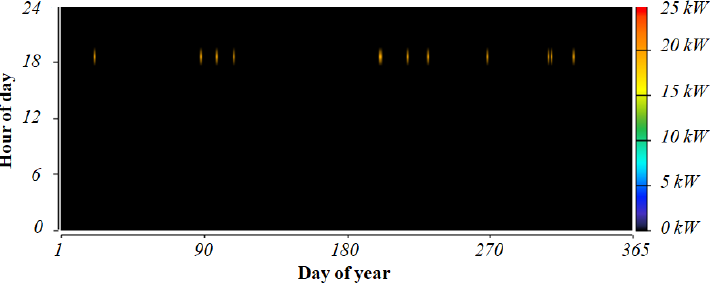
Figure A3. Power output from DG in HEGS combination 3.